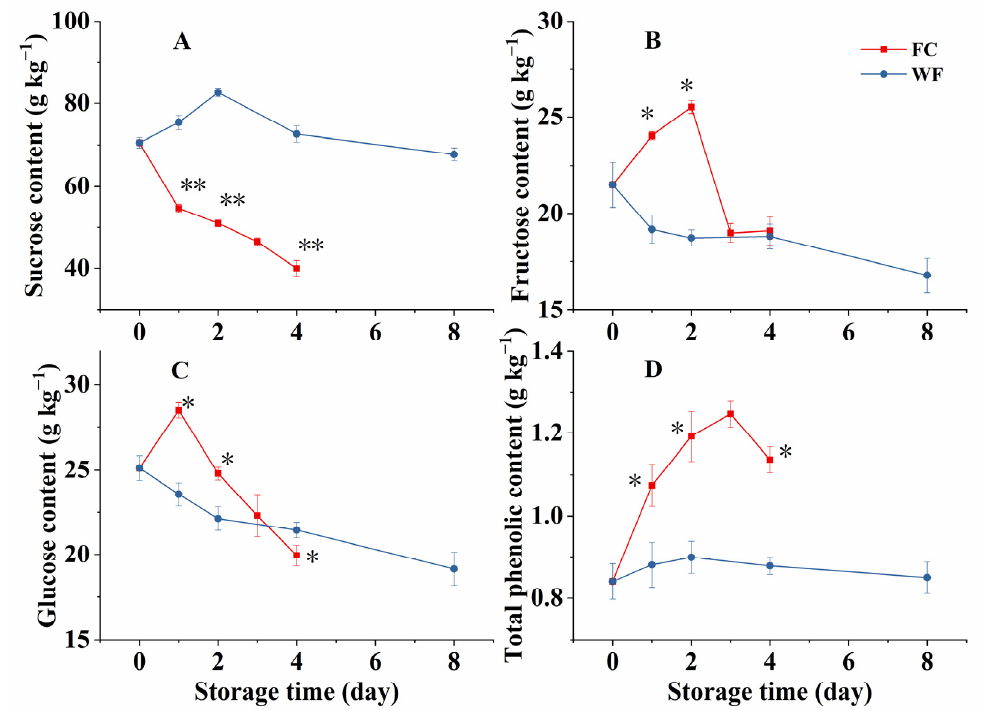
Figure 1. Effect of cutting on the contents of sucrose ( A ), fructose ( B ), glucose ( C ) and total phenolic ( D ) in melon fruit during storage (15 °C). FC and WF respectively represent fresh-cut and whole melon fruit. The values are expressed as means ± SE of three replicates. * and ** indicate statistically significant differences ( p < 0.05 and p < 0.01 respectively) according to Student’s t -test at each sampling point.